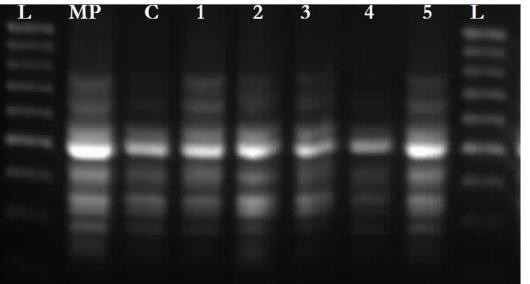
Figure 6. A band pattern produced by UBC 17 primer for shoots: Ladder (L), Mother plant (MP), control (C), and M. oblongifolia shoots’ exposure to AgNPs treatments (1, 2, 3, 4, and 5) represent AgNPs treatment 10, 20, 30, 40, and 50 mg/L, respectively.